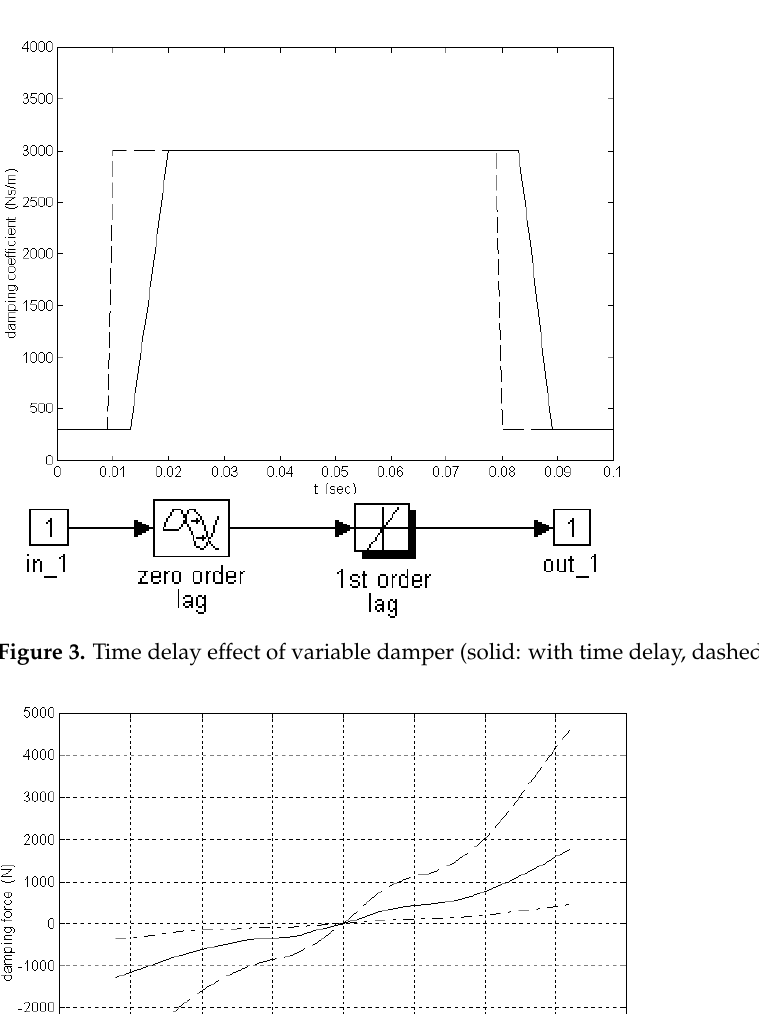
Table 1. Model parameters for the quarter car.